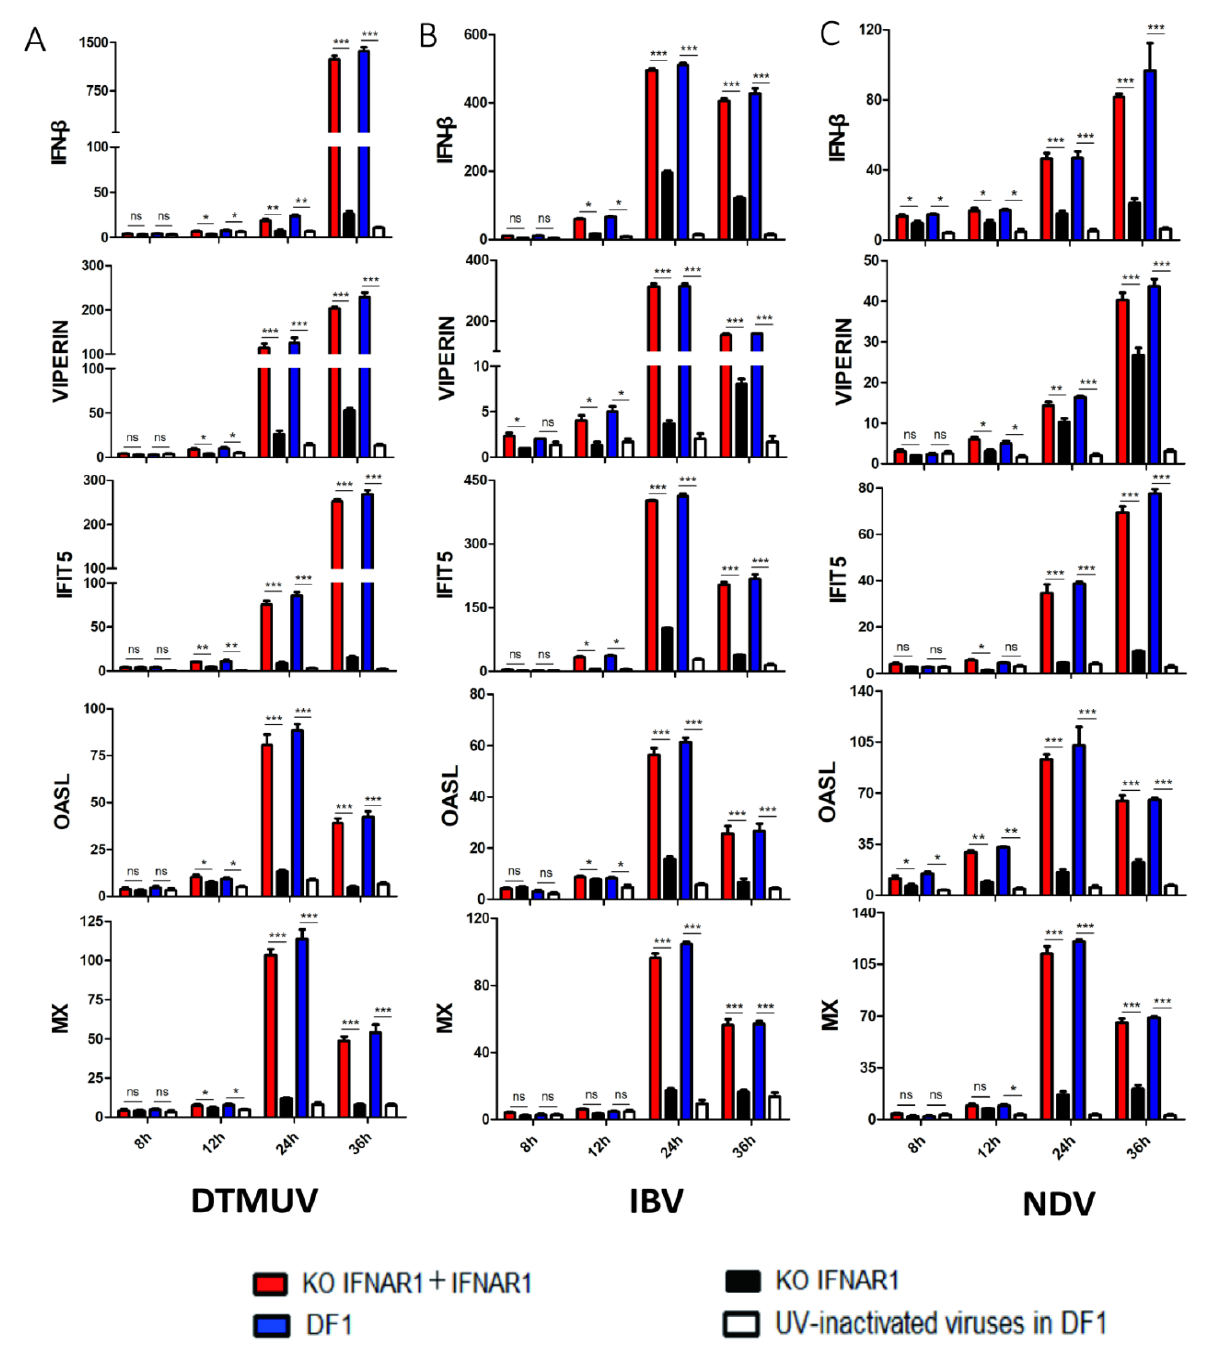
Figure 2. Suppression of ISG induction in IFNAR1-knockout cells infected with DTMUV, IBV and NDV, respectively. The mRNA levels of IFN- β , VIPERN, IFIT5, OASL and MX in cells infected with DTMUV ( A ), IBV ( B ) and NDV ( C ) were detected by RT-qPCR. T tests were conducted between the FINAR1 overexpressed cells (red) and mock cells in KO-IFNAR1 (black), and were conducted between the wild type DF-1 cells (blue) and UV-inactivated viruses treated DF-1 cells (white). * p < 0.05; ** p < 0.01; *** p < 0.001; ns, non-significant.